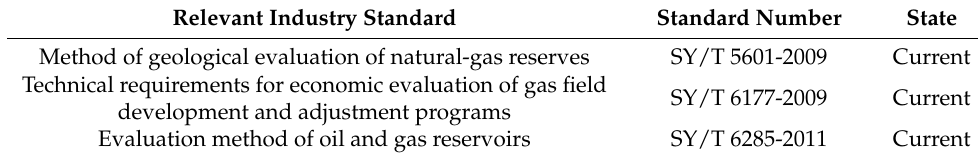
Table 1. Relevant industry standards.